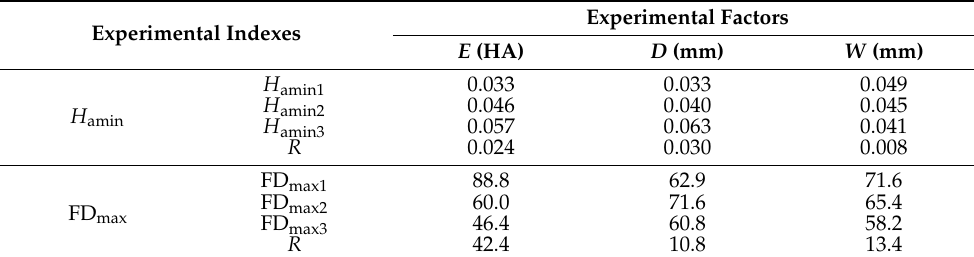
Table 3. Minimum closing pressure ( H amin ) and maximum flushing duration (FD max ) range analysis of the automatic flushing valve.